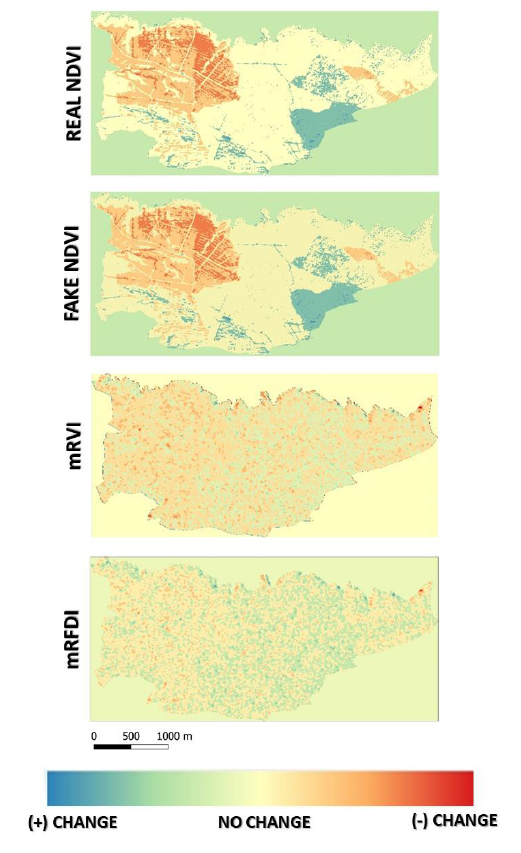
Figure 8. Difference maps for all vegetation indices and Cycle-GAN based fake